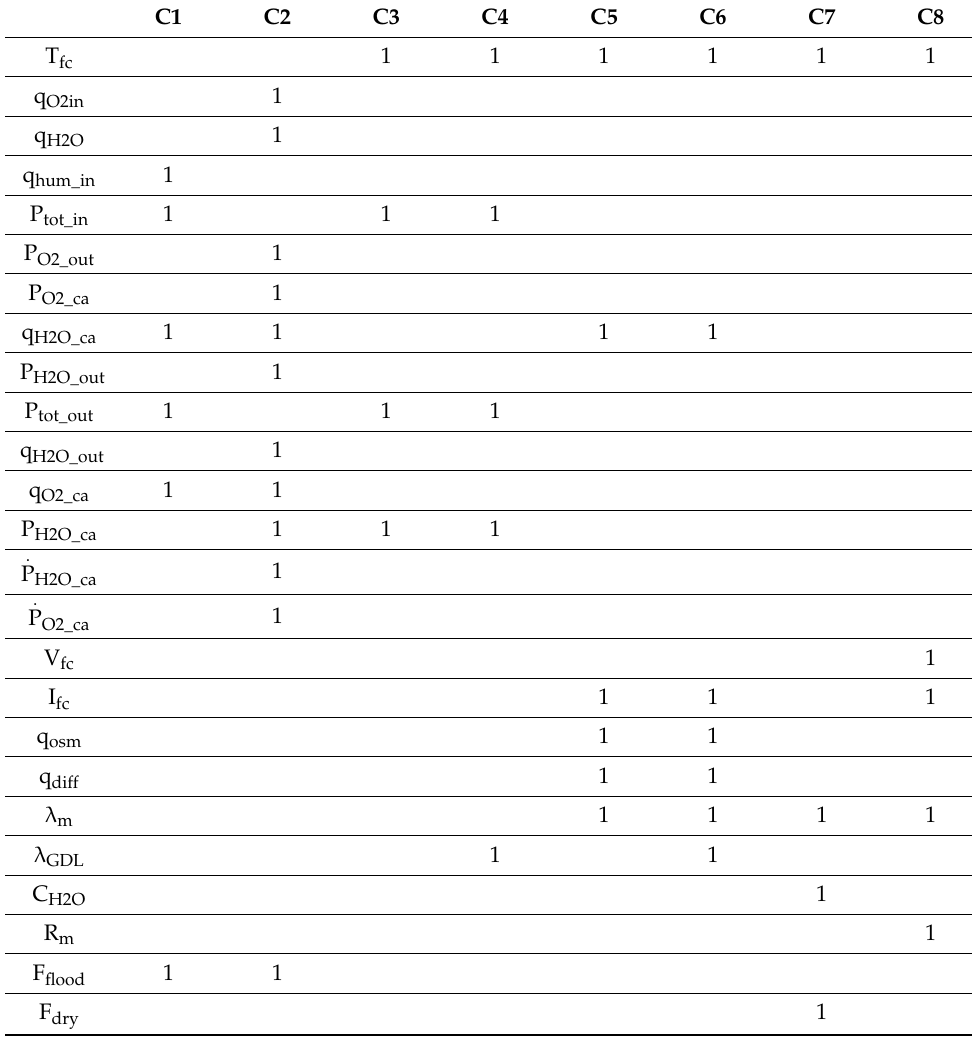
Table 3. Incidence matrix updated with the membrane drying out